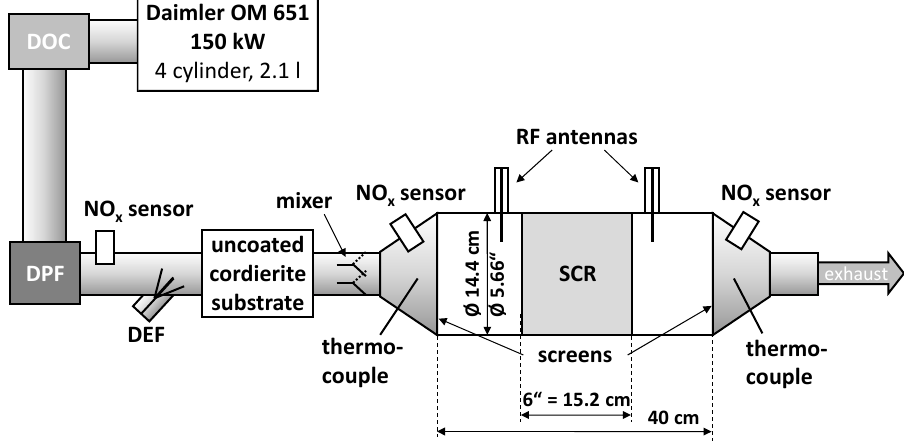
Figure 1. Illustration of the dynamometer setup: 2.1 l diesel engine with diesel oxidation catalyst and particulate filter, DEF dosing with uncoated cordierite substrate and plate mixer, Ø 5.66” (Ø 14.2 cm) SCR catalyst canning defined by metal screens with two RF antennas, thermocouples up- and downstream of the SCR and three NO x sensors up- and downstream of SCR and upstream of DEF dosing.